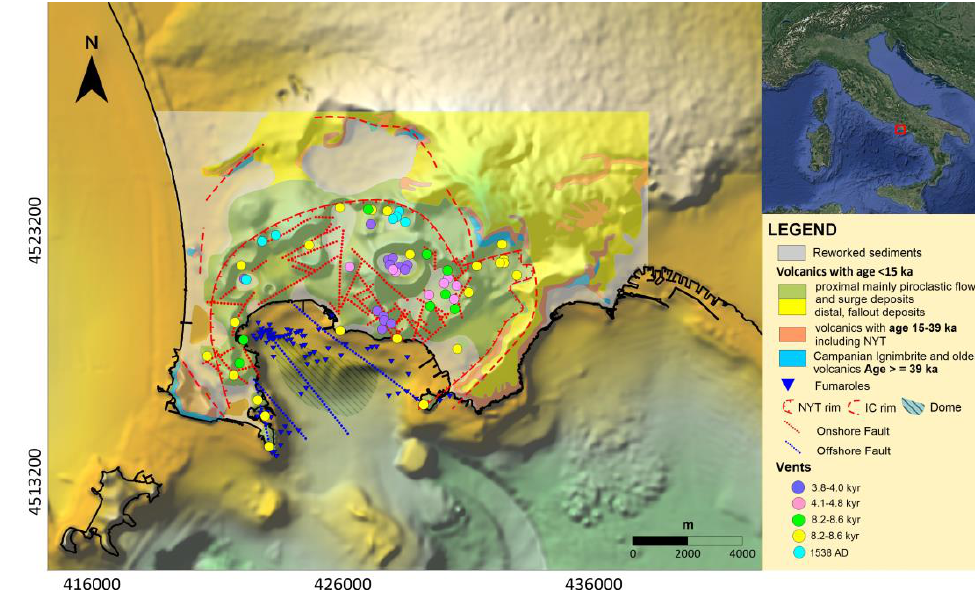
Figure 1. Geo-structural map of the Phlegraean Fields areas. Faults and caldera rims modified by Vitale and Isaia 2014 [22], resurgent dome modified by Steinmann et al. 2016 [23], vents modified by Piochi et al. 2014 [24], fumarole modified by De Bonitatibus et al. 1970 [25]. In the upper right Google Earth inset, the study area.